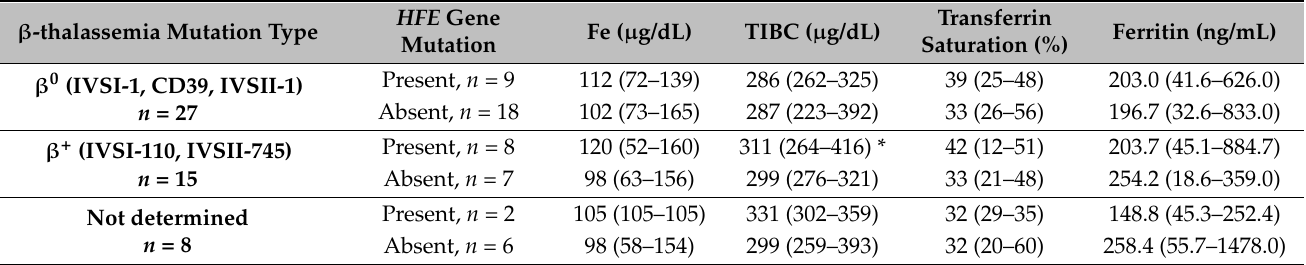
Table 3. Influence of the presence of HFE gene mutation on iron metabolism according β -thalassemia mutation